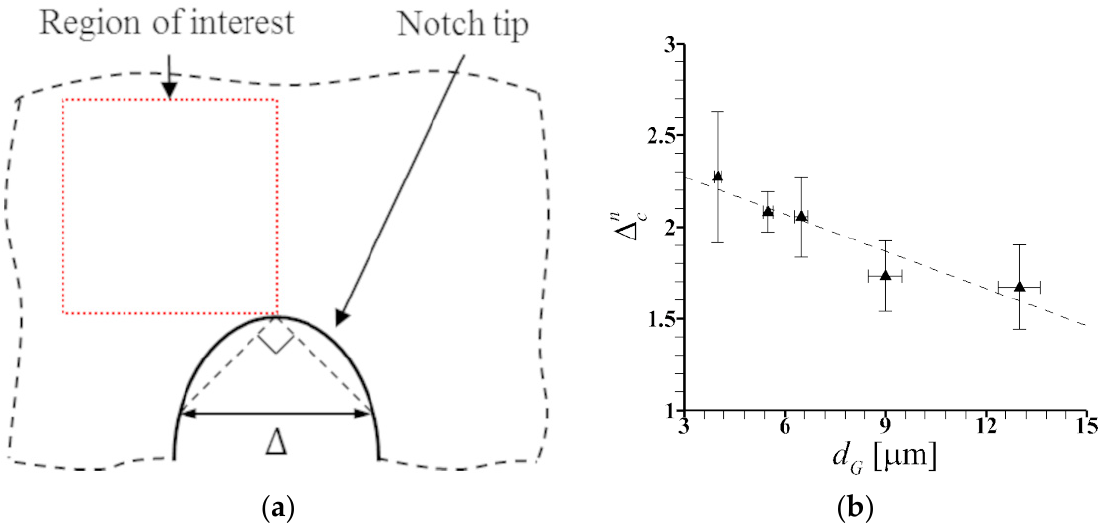
Figure 6. ( a ) Schematic showing a magnified view of the notch in a single-edge notch specimen and the definition of the crack-tip opening displacement, ∆ . ( b ) Variation in the normalized critical crack-tip opening displacement, ∆ n c , with average prior austenite grain size, d G .